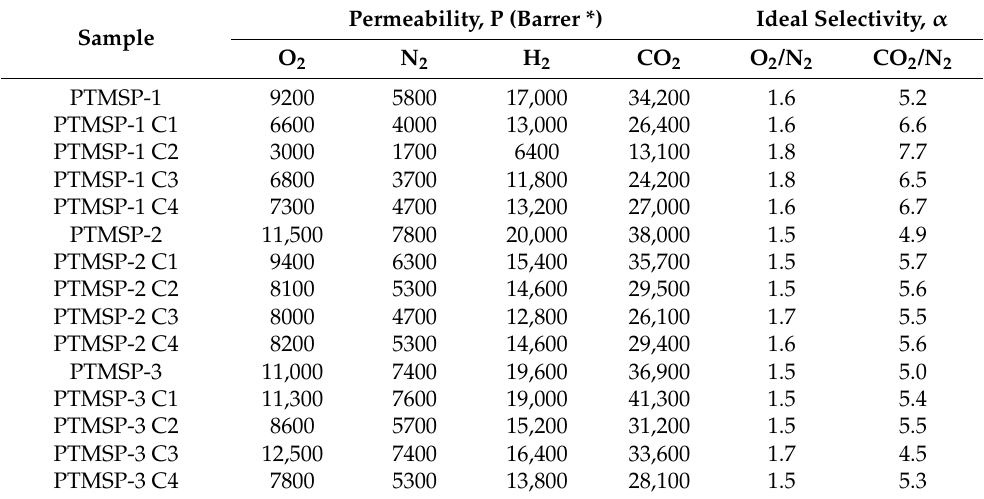
Table 2. Individual gas permeability coefficients of freshly prepared nonstabilized PTMSP films and films containing stabilizers Irganox 1010 (C1), Vulkanox BKF (C2), Vulkanox BHT (C3), and Irganox 1076